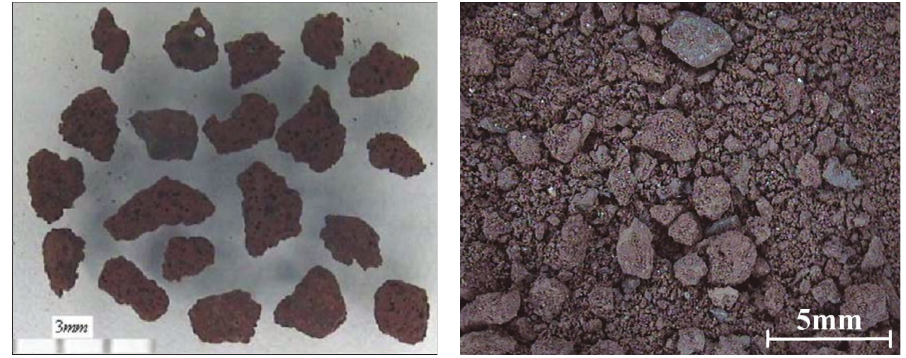
Figure 1: SEM image of TJ-1